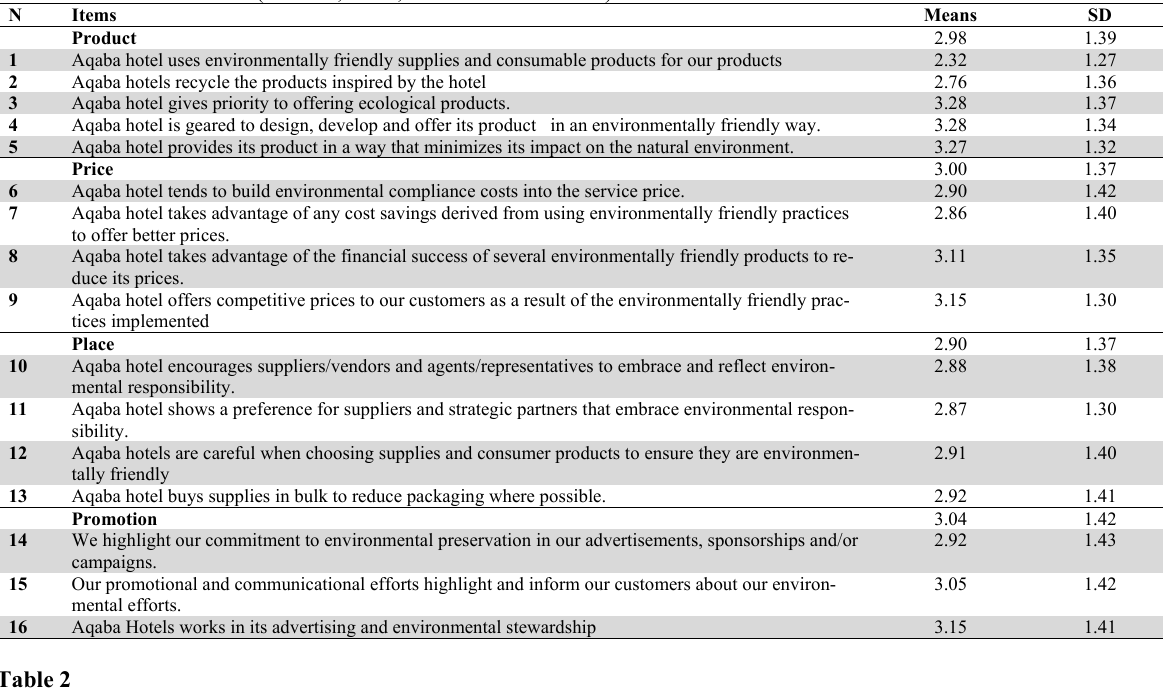
Means Standard divination (Product, Price, Place and Promotion)